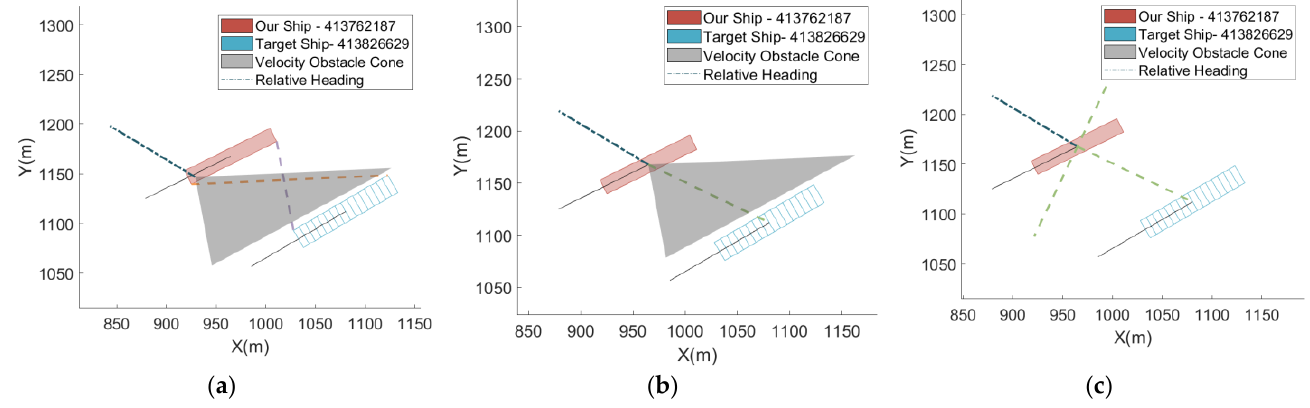
Figure 14. Comparison of DVOI/TVOI and CPA in Case 1. ( a ) The absolute velocity obstacle cone used to calculate DVOI, ( b ) the relative velocity obstacle cone used to calculate TVOI, ( c ) used to calculate DCPA and TCPA. Table 3. Risk assessment results of Case 1.